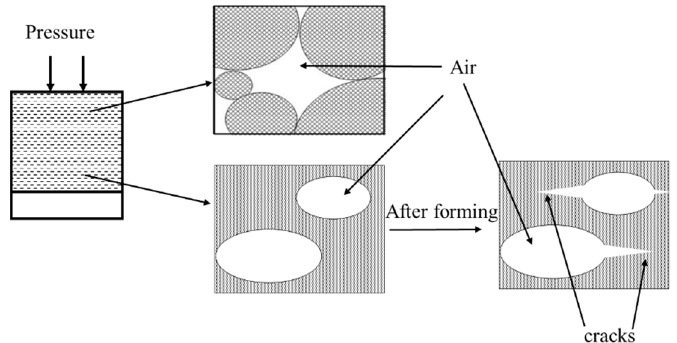
Figure 3. Schematic illustration of the entrapped-air induced defects inside the green body.